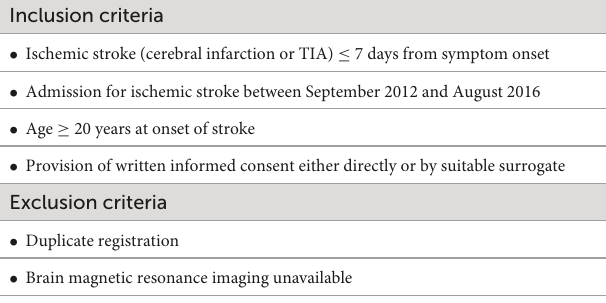
TABLE 1 Eligibility criteria for patient registration in the ischemic stroke cohort. Inclusion criteria